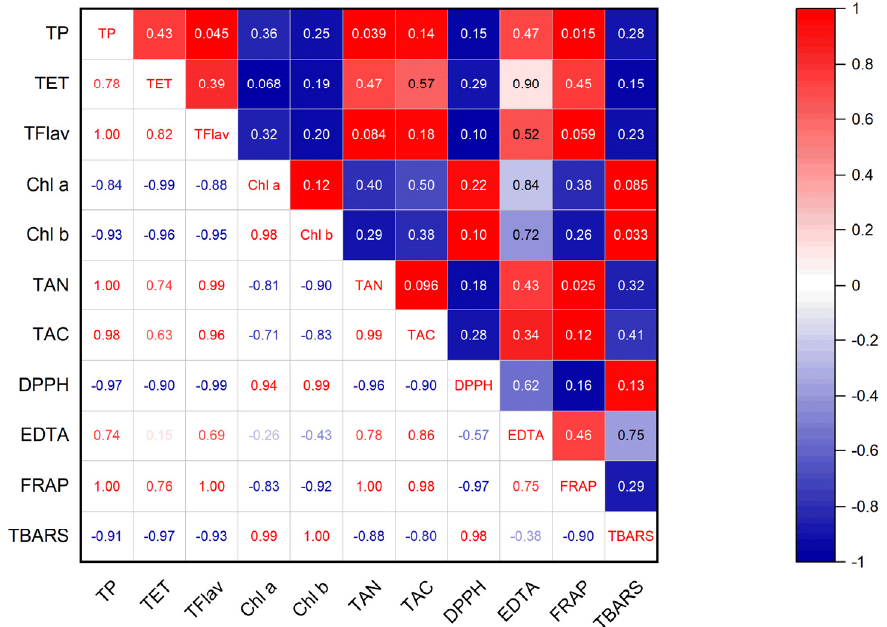
Figure 3. Correlation coefficients of antioxidant activities and polyphenol content. The numbers in the lower triangular represent correlation values; positive values mean positive correlation, whereas negative values mean negative correlation. In the upper triangular, dark red represents significant positive correlation; dark blue means significant negative correlation, and the numbers signify the p value ( p < 0.05).